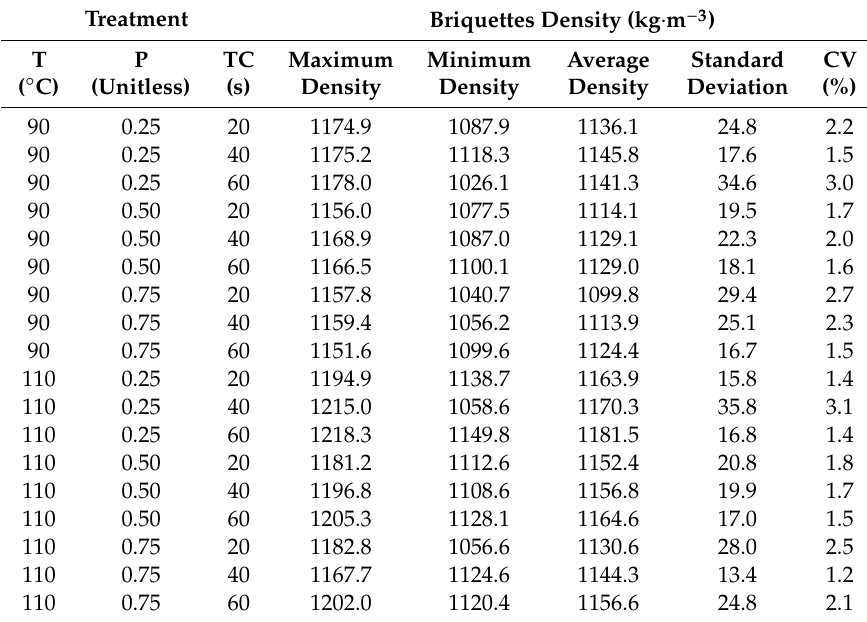
Table 4. Results for density in rice husk and pine sawdust